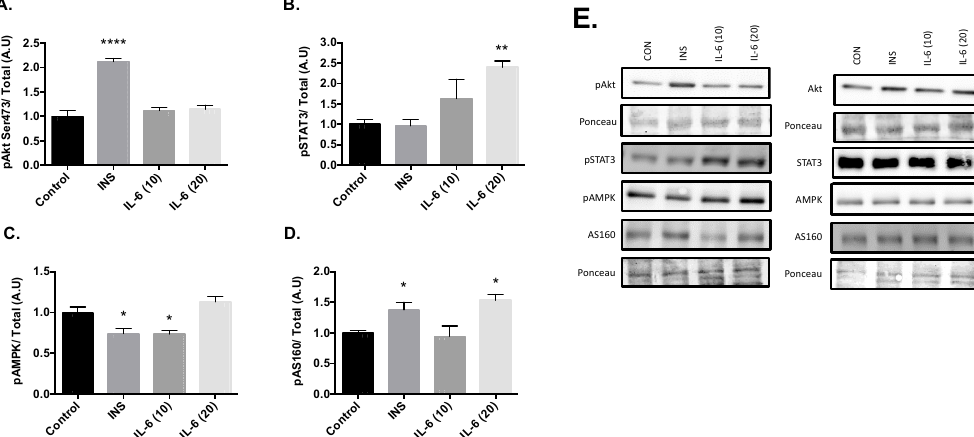
Figure 1. Effects of Acute Insulin and IL-6 Treatment of SH-SY5Y Cells. SH-SY5Y cells were treated with 100nM of insulin, 10ng/mL of IL-6, or 20ng/mL of IL-6 for 30 min. ( A ) Acute insulin treatment significantly increases phosphorylation of Akt at the Serine 473 Site (n = 3 per group). ( B ) Acute IL-6 treatment significantly increases phosphorylation of STAT3 at Tyrosine 705 (n = 3 per group). ( C ) Acute insulin and IL-6 treatment significantly decreases phosphorylation of AMPK (n = 3 per group). ( D ) Acute insulin and IL-6 treatment significantly increases phosphorylation of AS160 (n = 3 per group). ( E ) Representative blots are shown beside the quantified data. Data are presented as means ± SE. A.U., arbitrary units. * p ≤ 0.05, ** p ≤ 0.01, **** p ≤ 0.001, as determined using a one-way ANOVA